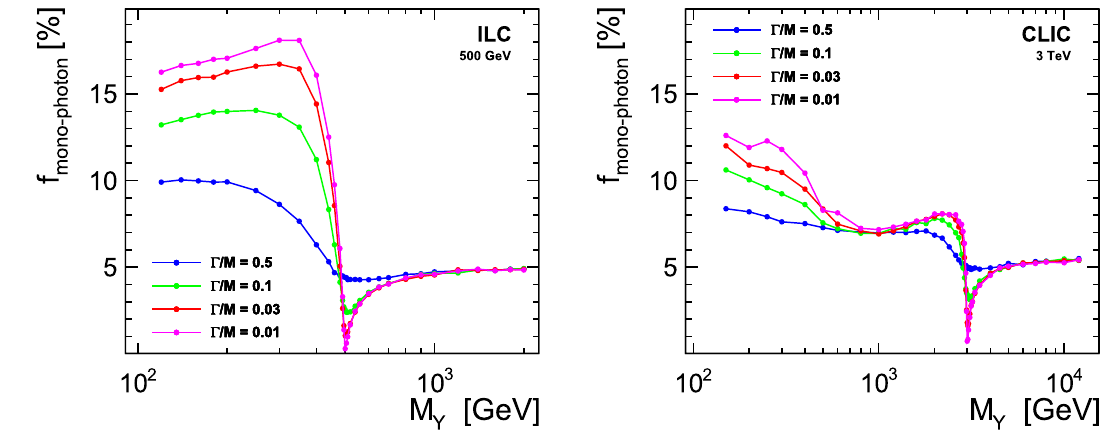
Fig. 6 Fraction of dark matter pair-production events, which are reconstructed as mono-photon events in the detector, as a function of the assumed mediator mass, for the ILC running at 500GeV (left) and CLIC running at 3TeV (right) and different fractional mediator widths, as indicated in the